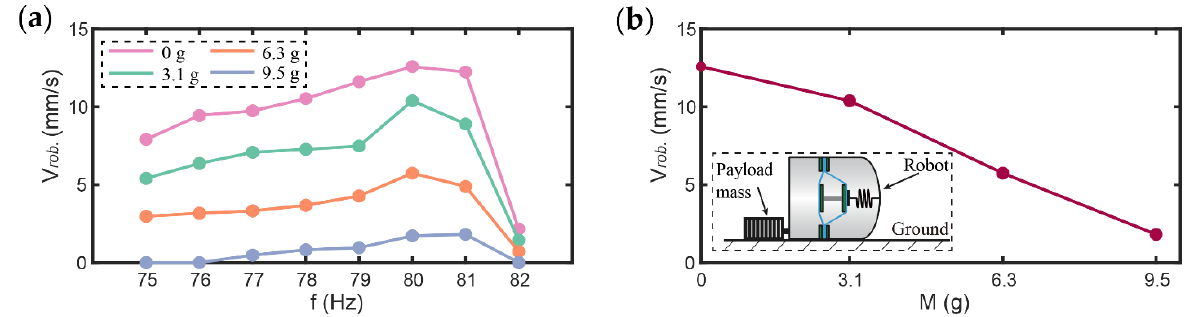
Figure 10. ( a ) The velocity of the robot with load mass of 0, 3.1, 6.3, and 9.5 g; ( b ) Effects of load mass on the velocity of the robot.